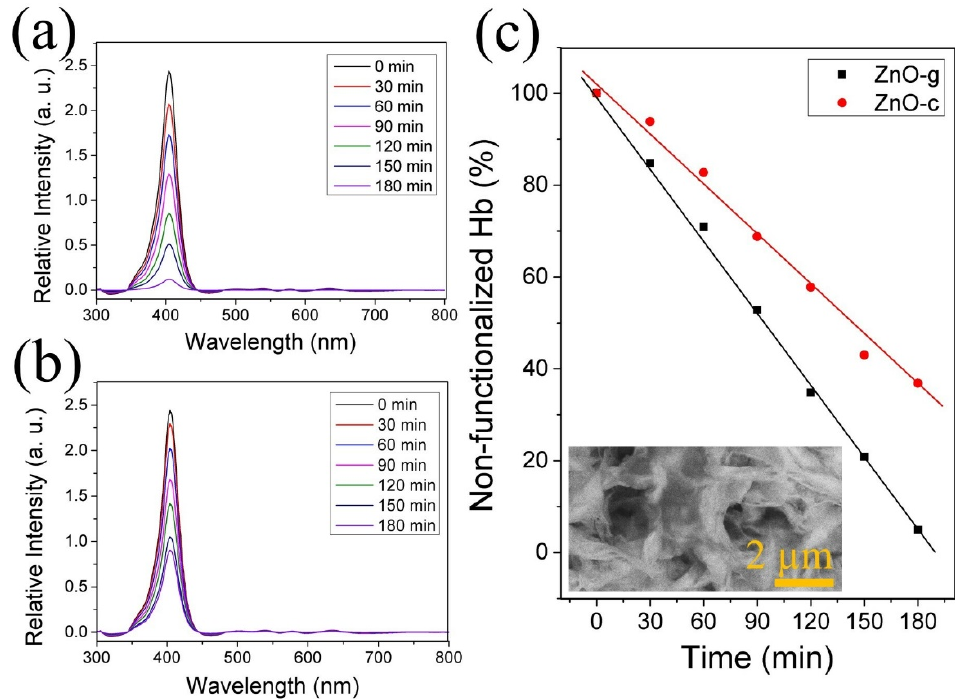
Figure 6. Measured absorbance by UV–Vis of the remanent hemoglobin in the functionalization process over time with ( a ) grass-like and ( b ) cane-like structures. ( c ) Relationship between absorbance signal over time of supernatant in the Hb-functionalization process. Insert in ( c ) shows a Hb- functionalized sample imaged by SEM.